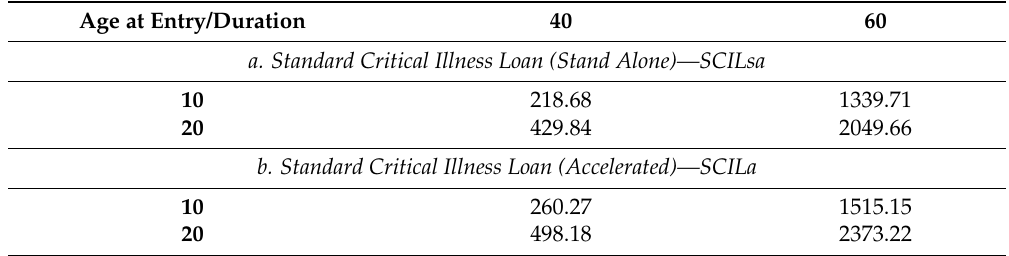
Table 5. Actuarial periodic premium—male non-smokers. Issue time 2014, r = 2%, i = 7%, C =